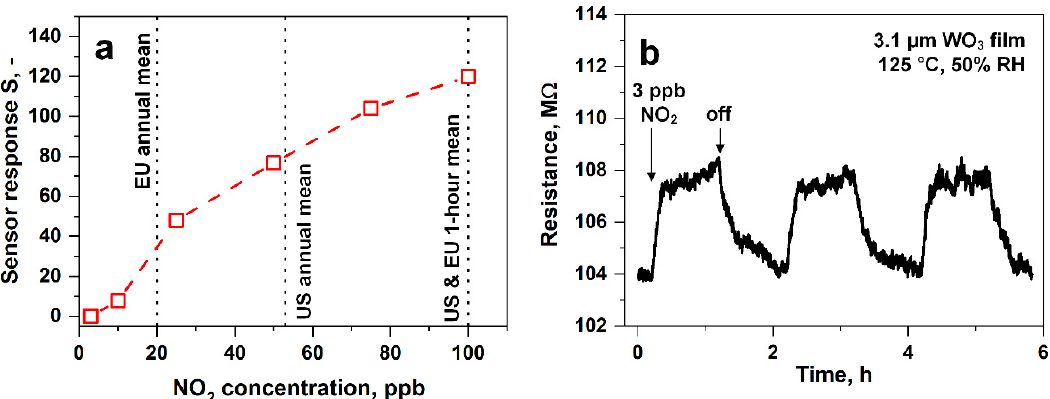
Figure 5. Low ppb NO 2 detection. ( a ) Sensor responses of the thickness-optimized WO 3 film (3.1 μ m) in the relevant concentration range from 3 to 100 ppb NO 2 measured at 50% RH (at 23 °C) and 125 °C. Threshold exposure limits from the EU [5] and the US [3] are indicated by dashed lines. ( b ) Film resistance upon consecutive exposure to 3 ppb NO 2 .